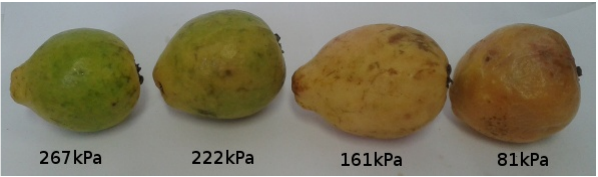
Figure 16. Turgor pressure in Kilo-Pascal (kPa) measured with the glove for guava. The fruit on the left is more unripe and the one on the right is more